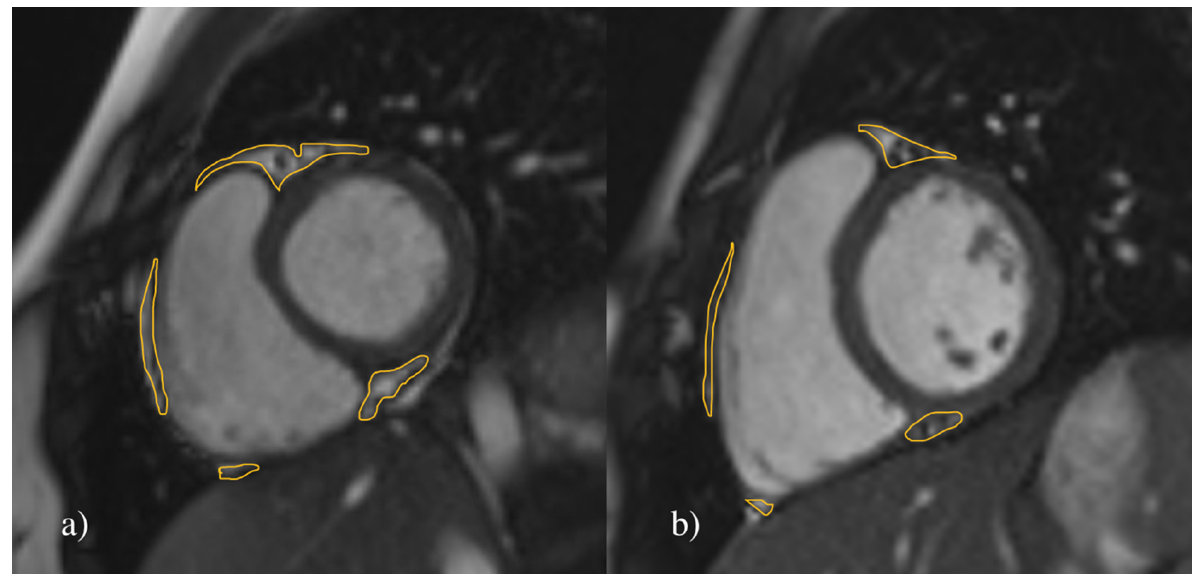
Figure 1. Measurement of the EAT volume. Representative MR short-axis image of the heart in cine SSFP sequence in 17-year-old females. Delineated areas demonstrate epicardial adipose tissue (EAT). The total measured EAT volume in ( a ) a hypertensive patient was 17.62 cm 3 and in ( b ) a healthy control was 10.35 cm 3 .